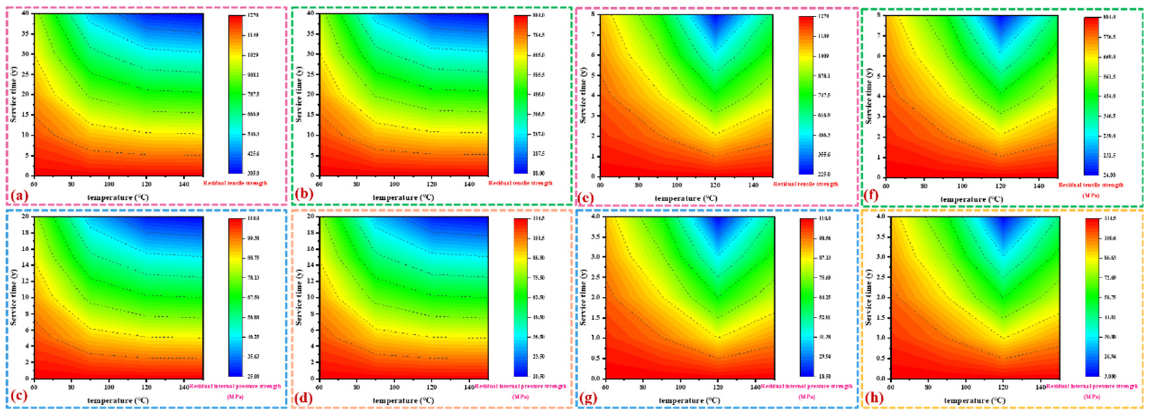
Figure 16. Residual tensile strength of T95 ( a , c , e , g ) and G3 ( b , d , f , h ) steels in gas ( a , b , e , f ) and liquid ( c , d , g , h ) phase (( a – d ): 0–2000 m; ( e – h ): 2000–4700 m).